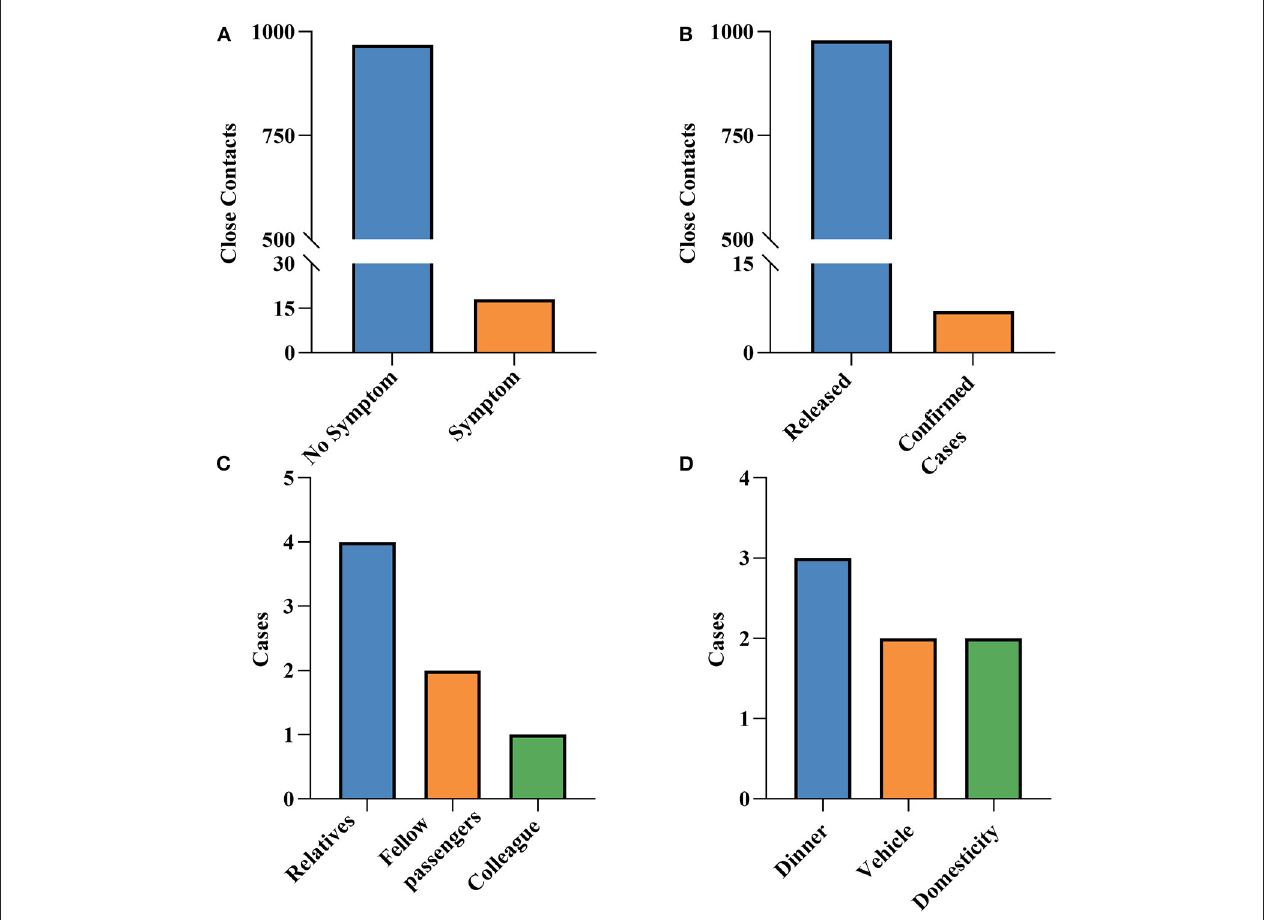
FIGURE 3 | The outcome of close contacts. (A) Whether they have symptoms or not. (B) Status of close contacts. (C) Relationship with indexed cases. (D) Contact mode with indexed